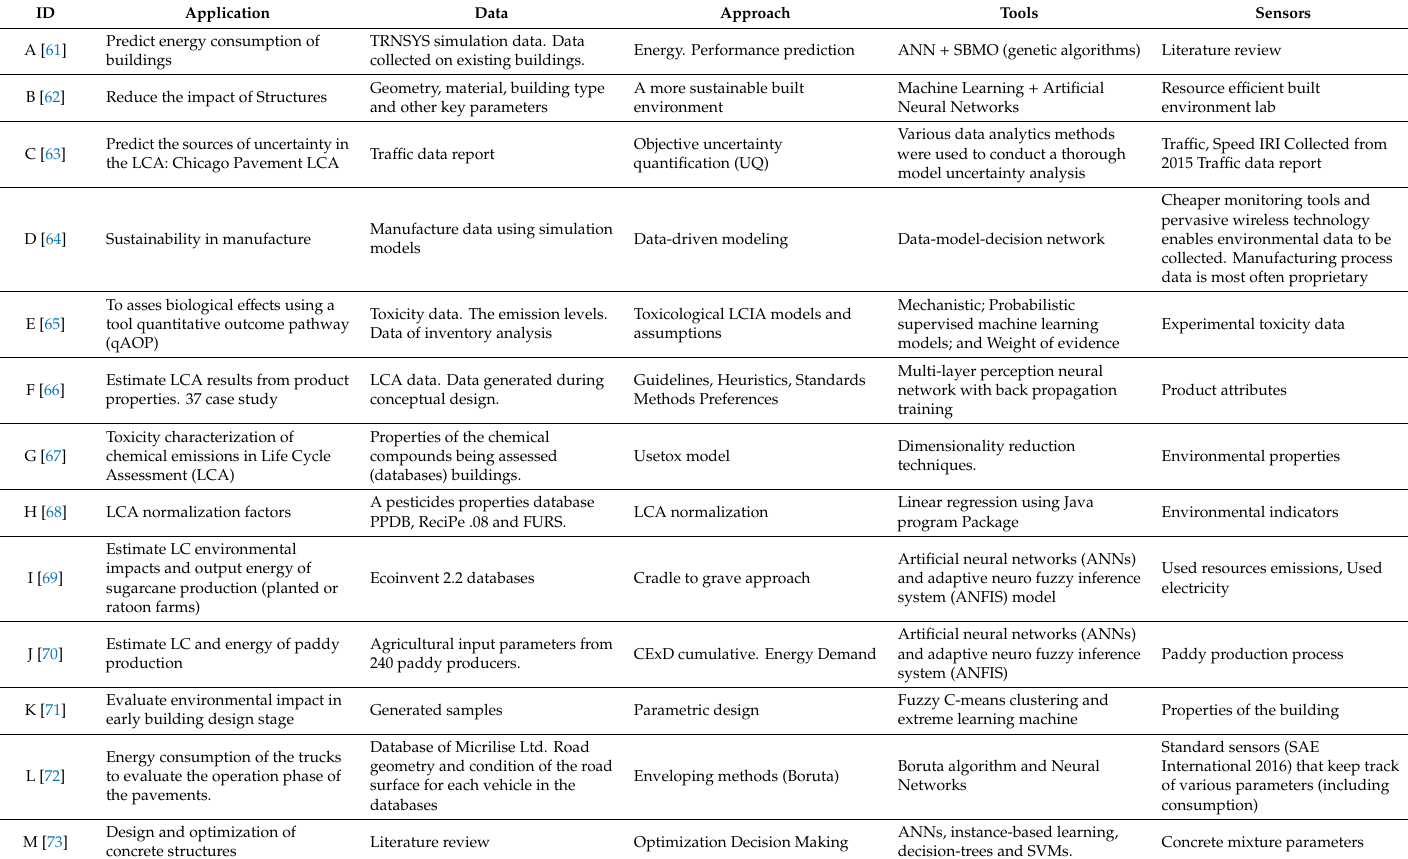
Table 3. Results for State of the